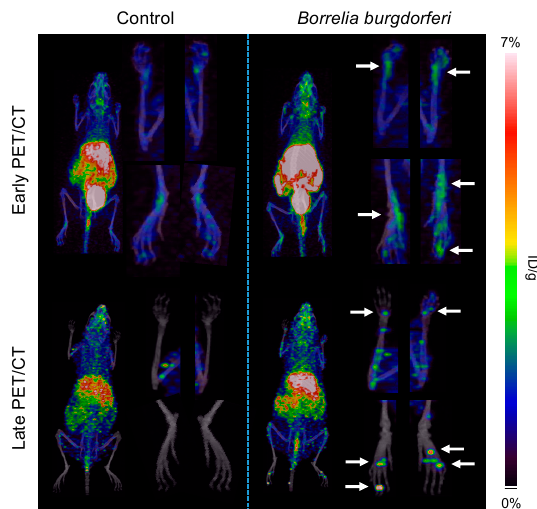
Figure 2. In vivo quantification of 64 Cu-DOTATATE uptake in collagen-induced arthritis (CIA) mice ( n = 7) and controls ( n = 4) . Data are presented as maximal percentage of injected dose per gram tissue (%Max ID/g) in each joint acquired 3 h p.i. Data are presented as mean ± SEM. The significance level is indicated by asterisks (*). p = 0.0032 (**).